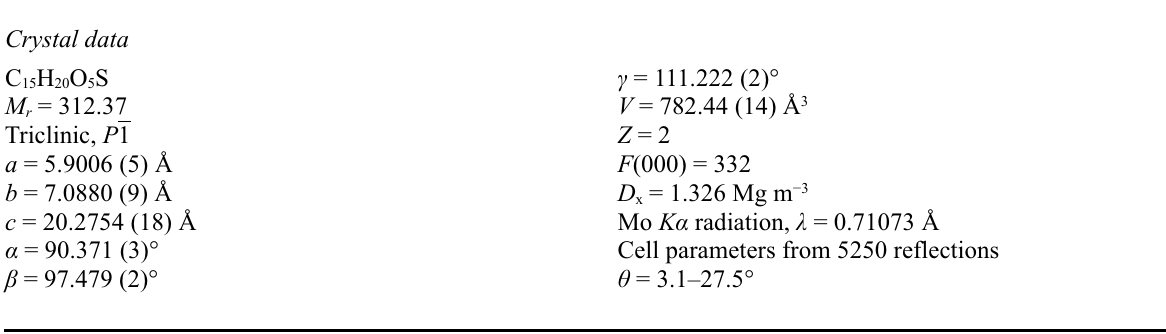
A packing diagram of the title compound. Intermolecular hydrogen bonds are shown as dashed lines. trans -4-(Tosyloxymethyl)cyclohexanecarboxylic